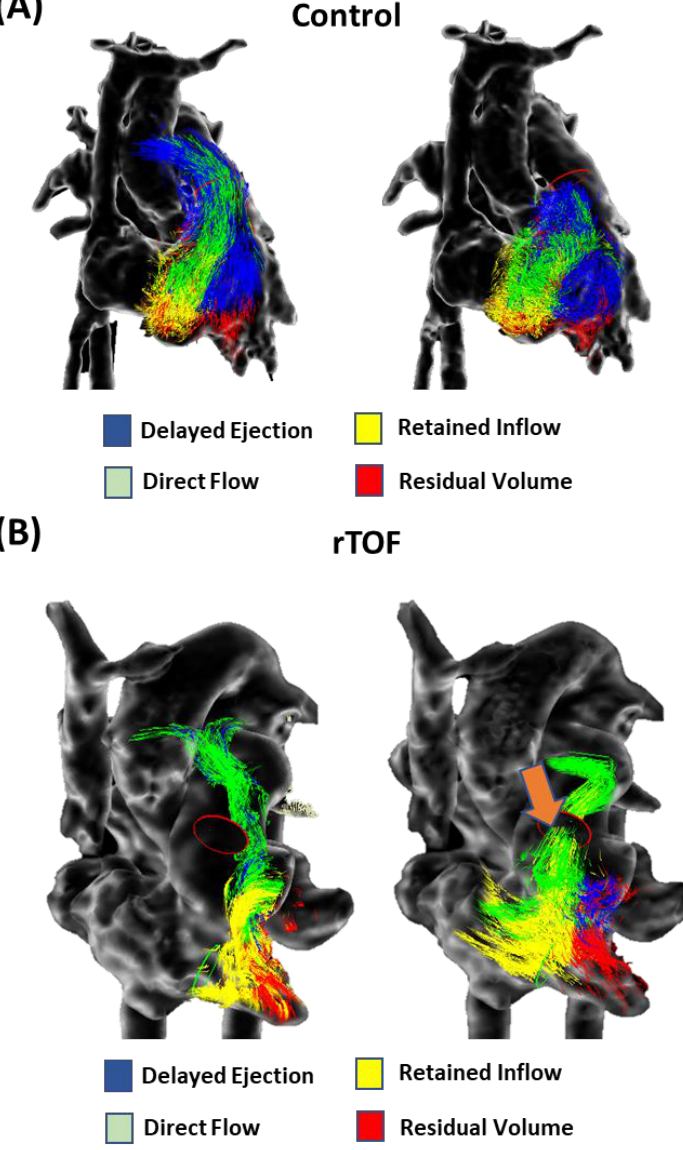
Figure 9. Comparison of ventricular flow analysis in a healthy control and a patient with repaired Tetralogy of Fallot. Panel ( A ) shows the ventricular flow analysis in a healthy control at peak systole (right) and early diastole (left). Panel ( B ) shows the ventricular flow analysis in a patient with repaired Tetralogy of Fallot (rTOF) with mild pulmonary regurgitation (orange arrow) at peak systole and early diastole.